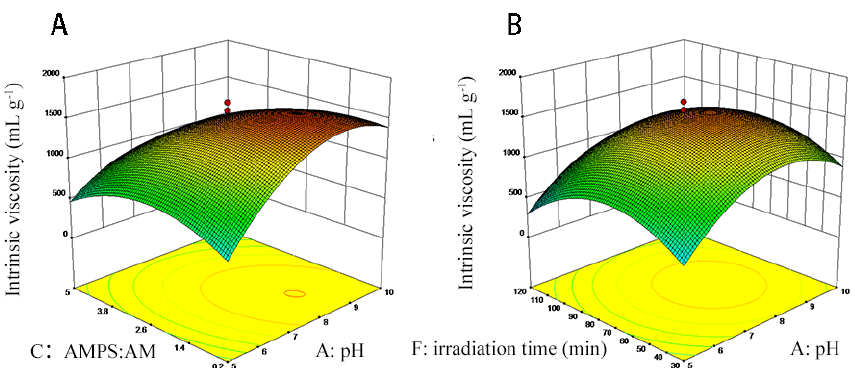
Figure 2. RSM analysis for the effect of pH coupled with mole ratio of AMPS/AM ( A ) and for the effect of pH combined with irradiation time ( B ).